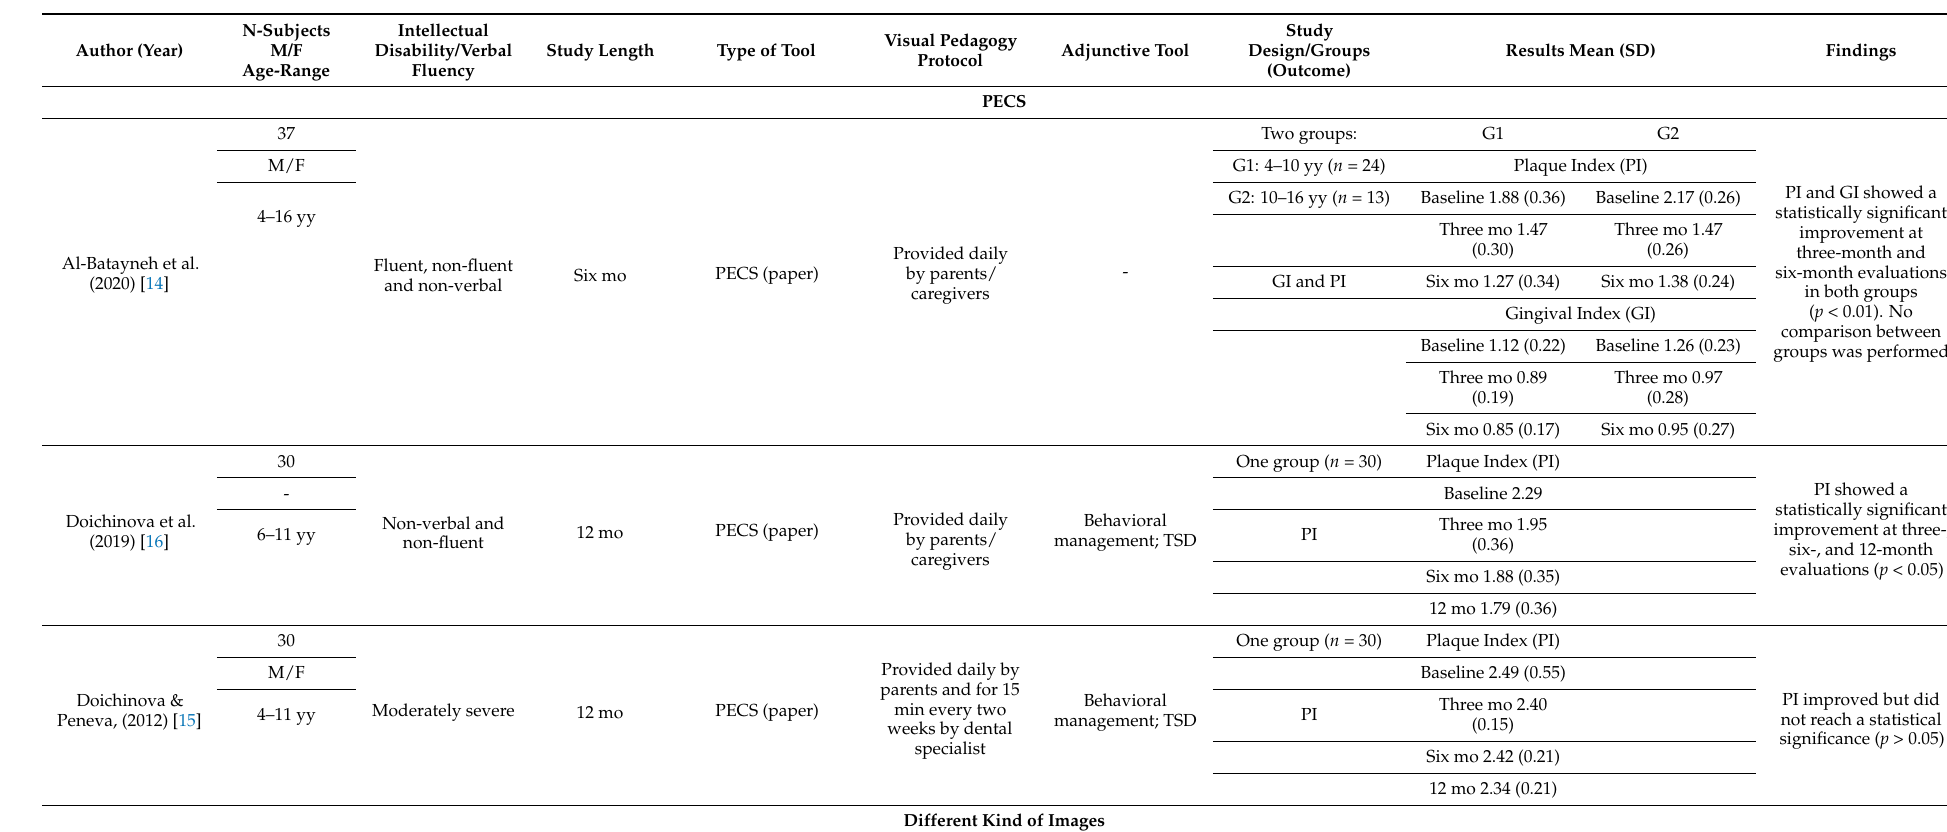
Table 2. Main characteristics of the included studies regarding the effectiveness of visual pedagogy in improving ASD children’s skills in oral